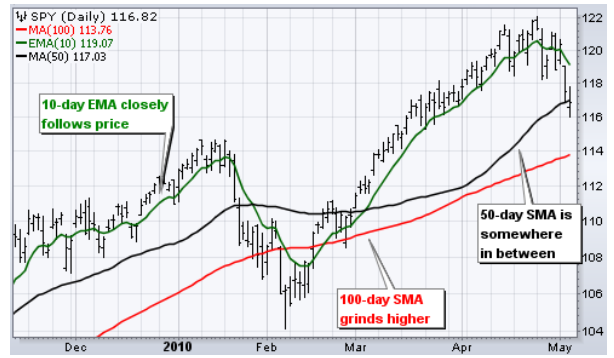
Fig. 3. Moving Average